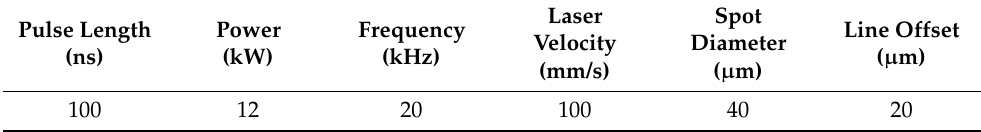
Table 1. Laser parameters for structures on ST2 and